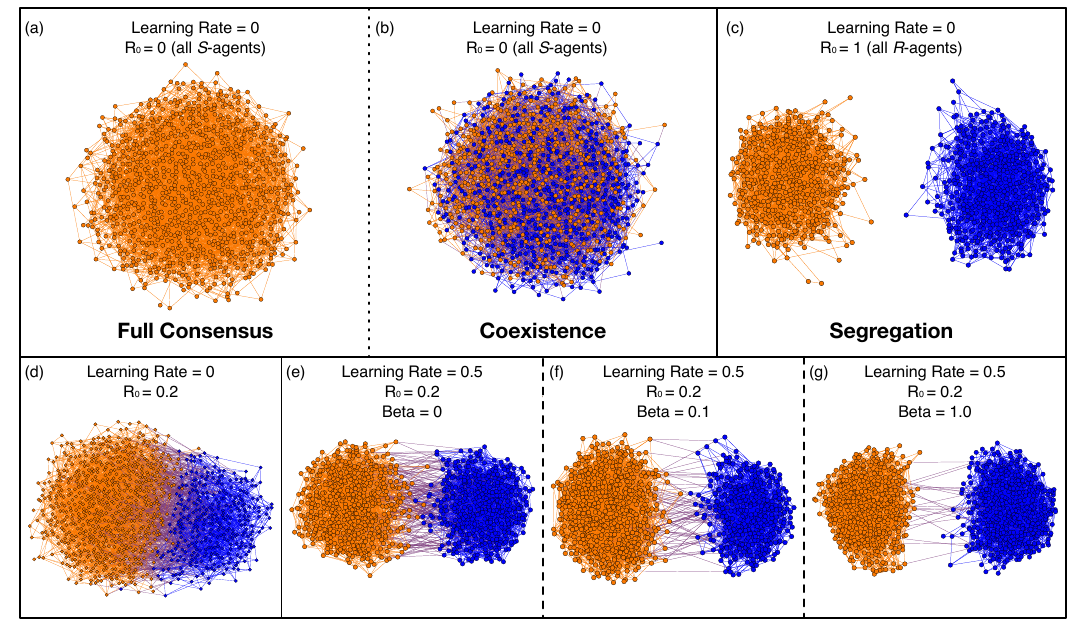
Figure 3. Final configuration states of the multiplex evident layer. Visualization of the actions (color codes) and link disposition according to model parameters ρ L (learning dynamics rate), β (hidden layer topology) and R 0 (initial fraction of R -agents). Full consensus ( a ) can only occur when only S -agents are present in the system, but not always; coexistence ( b ) is obtained otherwise, while segregation ( c ) and more profitable social outcomes in terms of game payoffs are reached when R -agents spread in the population. Other panels ( d – g ) show outcomes having an heterogeneous initial